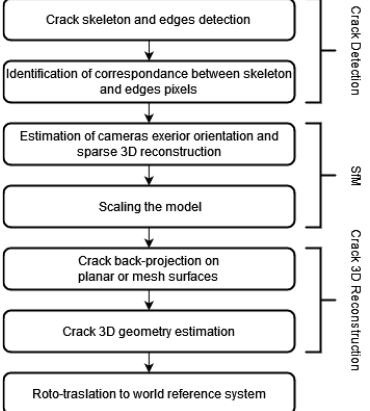
Figure 1 . Flow chart of the procedure illustrated in this paper for crack metric evaluation.